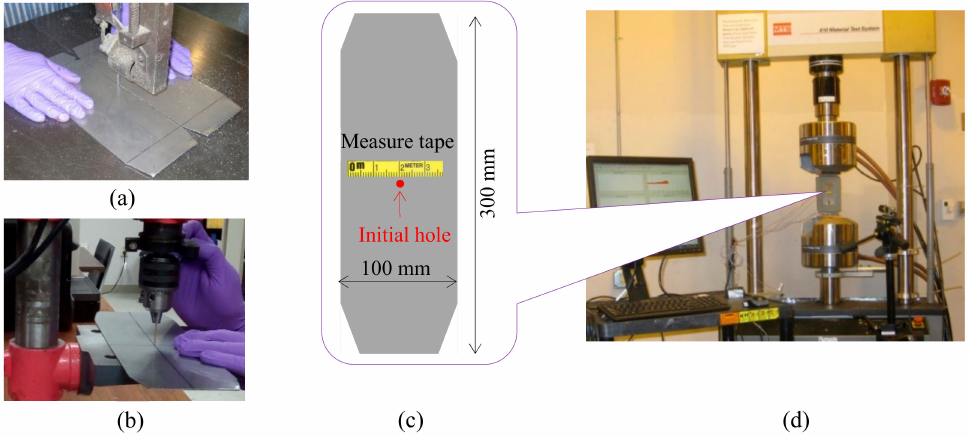
Figure 1. Experimental setup for fatigue testing: ( a ) Specimen preparation; ( b ) drill 1-mm hole at the center of the plate for crack initiation; ( c ) schematic of the fatigue specimen; and ( d ) the overall setup of the fatigue